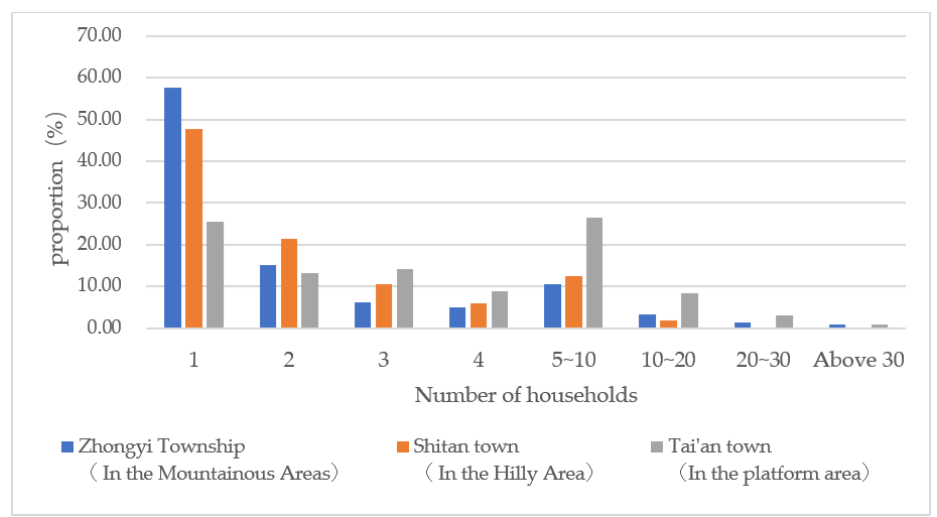
Figure 4. The statistics of the homestead polygon number in different landforms.